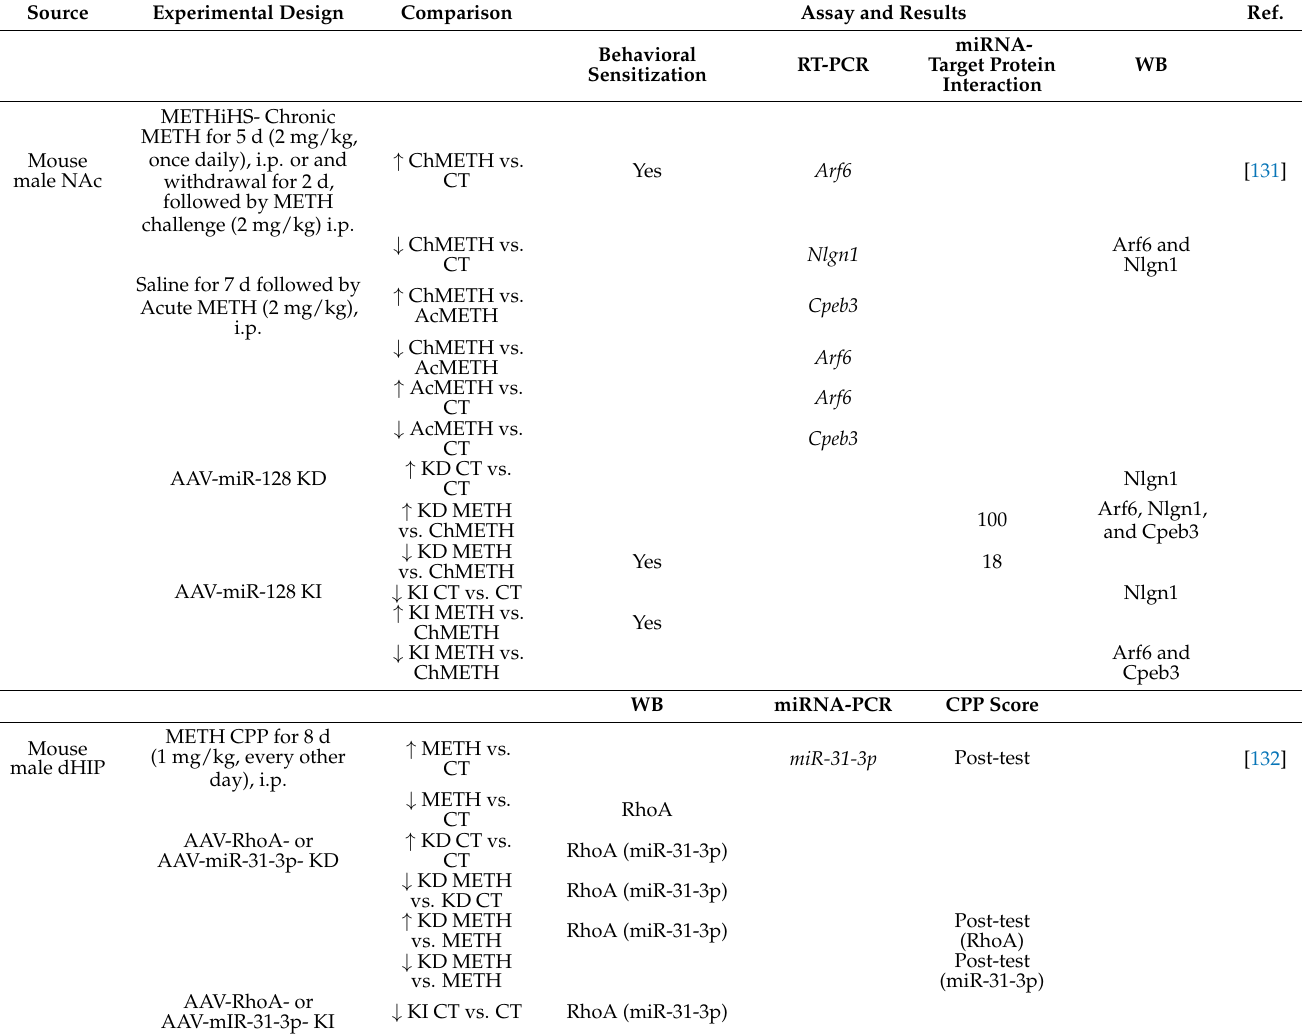
Table 3. Non-coding RNAs affected by METH